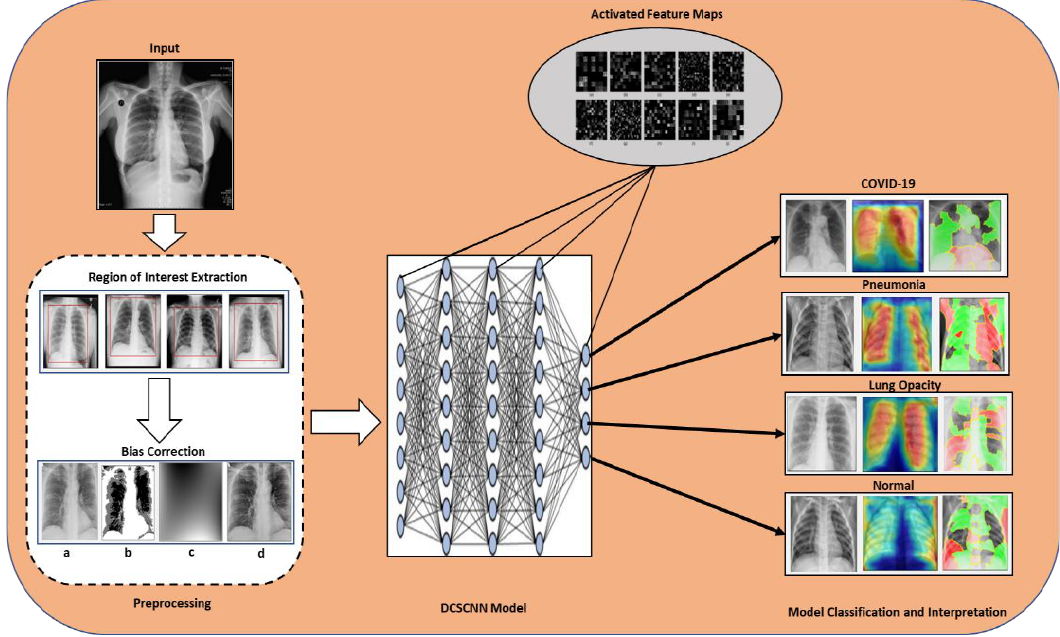
Figure 4. The overall architecture of the proposed densely connected squeezed convolutional neural network (DCSCNN) model.